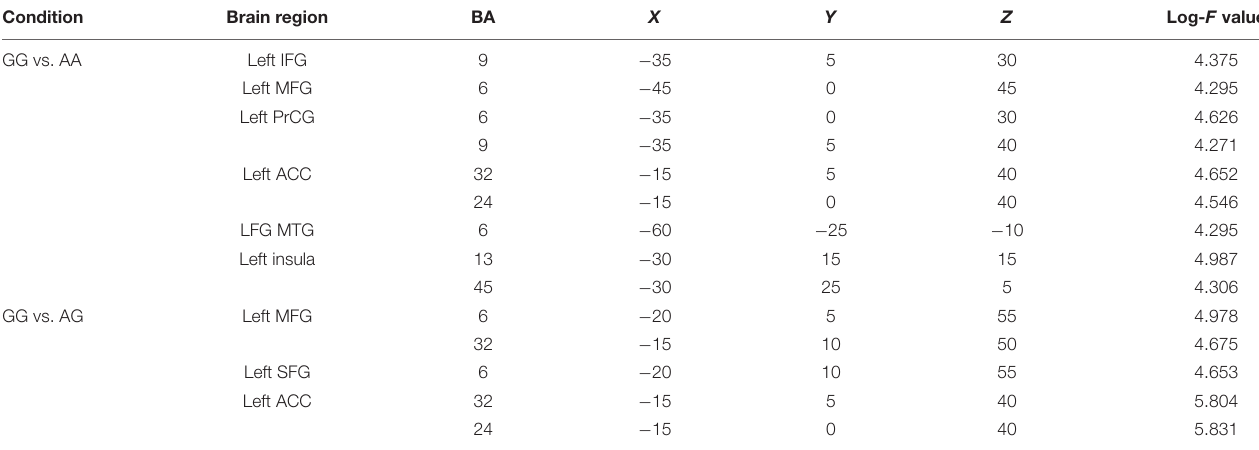
TABLE 1 | sLORETA Log -F statistics for maximum activations obtained from comparisons of the GG genotype with the AA and AG genotypes in the P2 time window (MNI coordinates). Condition Brain region BA X Y Z Log- F value GG vs. AA